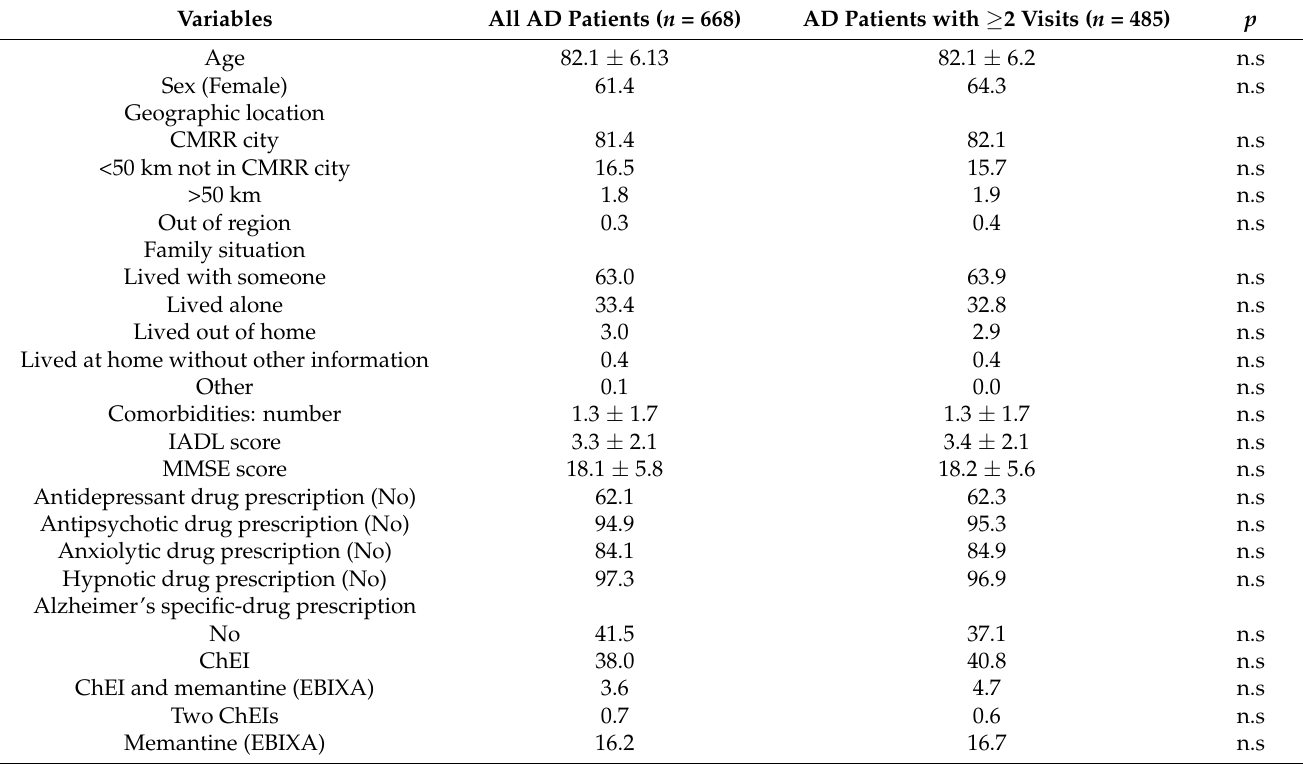
Table 1. Clinical and demographic characteristics at baseline.